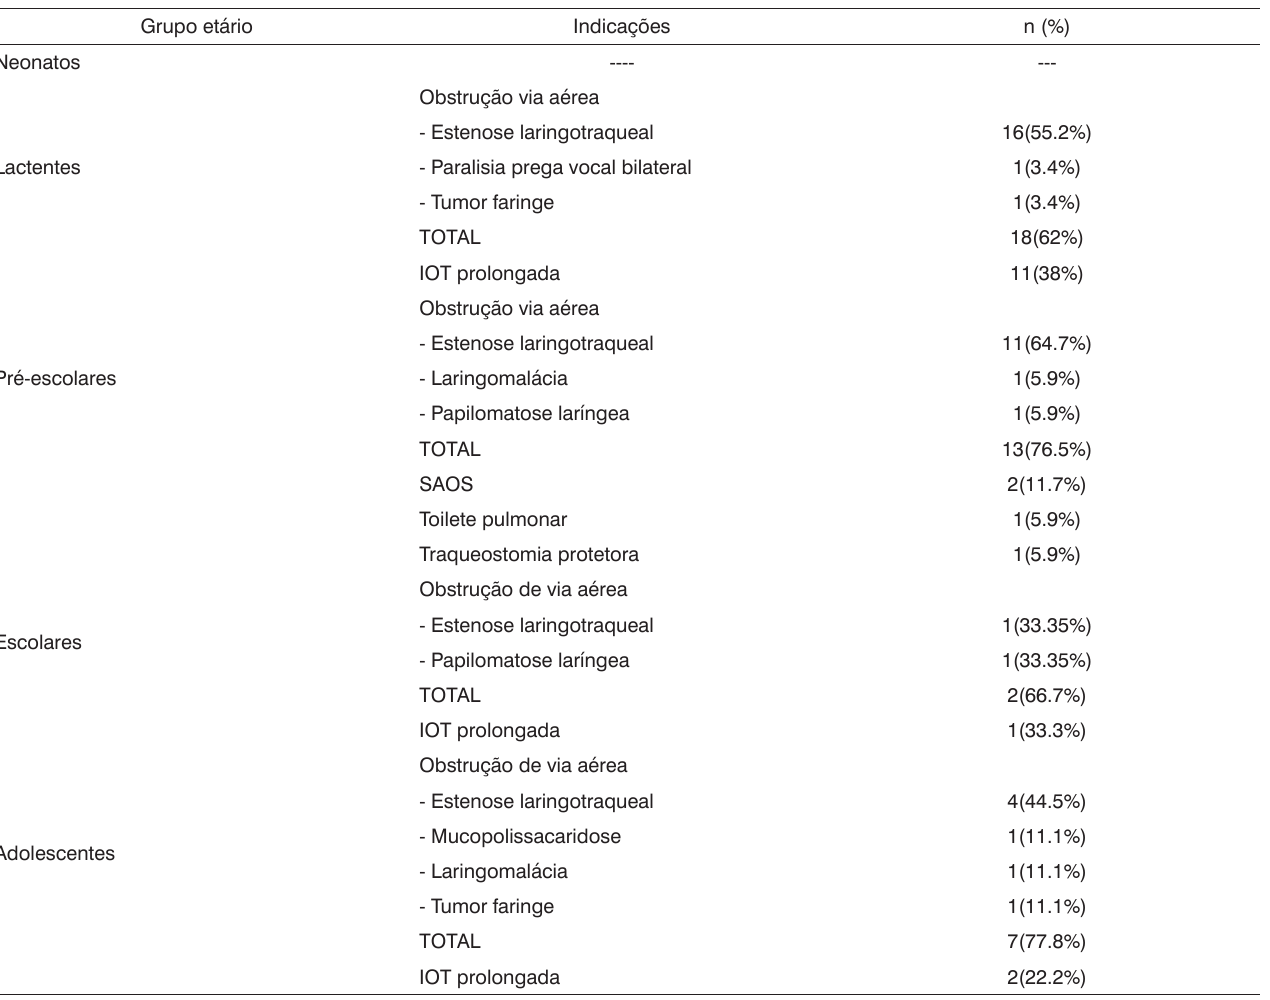
Tabela 3. Indicações de traqueostomia em cada grupo